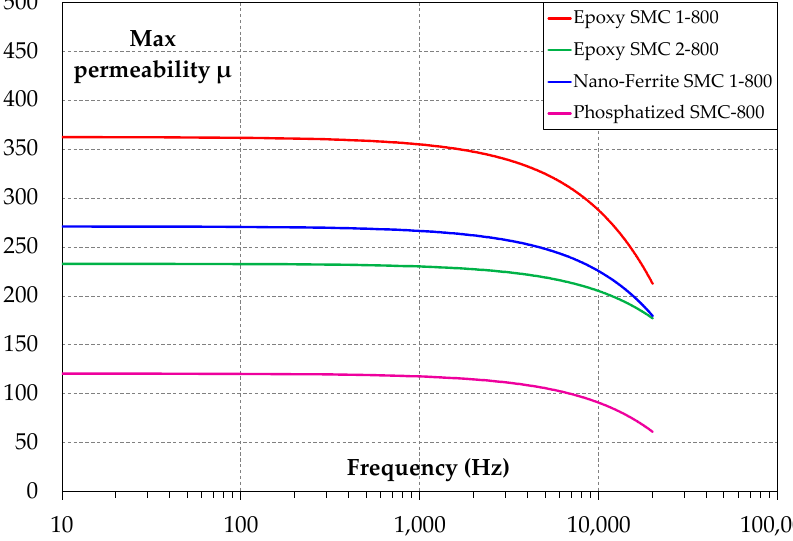
Figure 7. The maximum magnetic permeability of proposed toroid samples in a frequency range of 20 kHz .